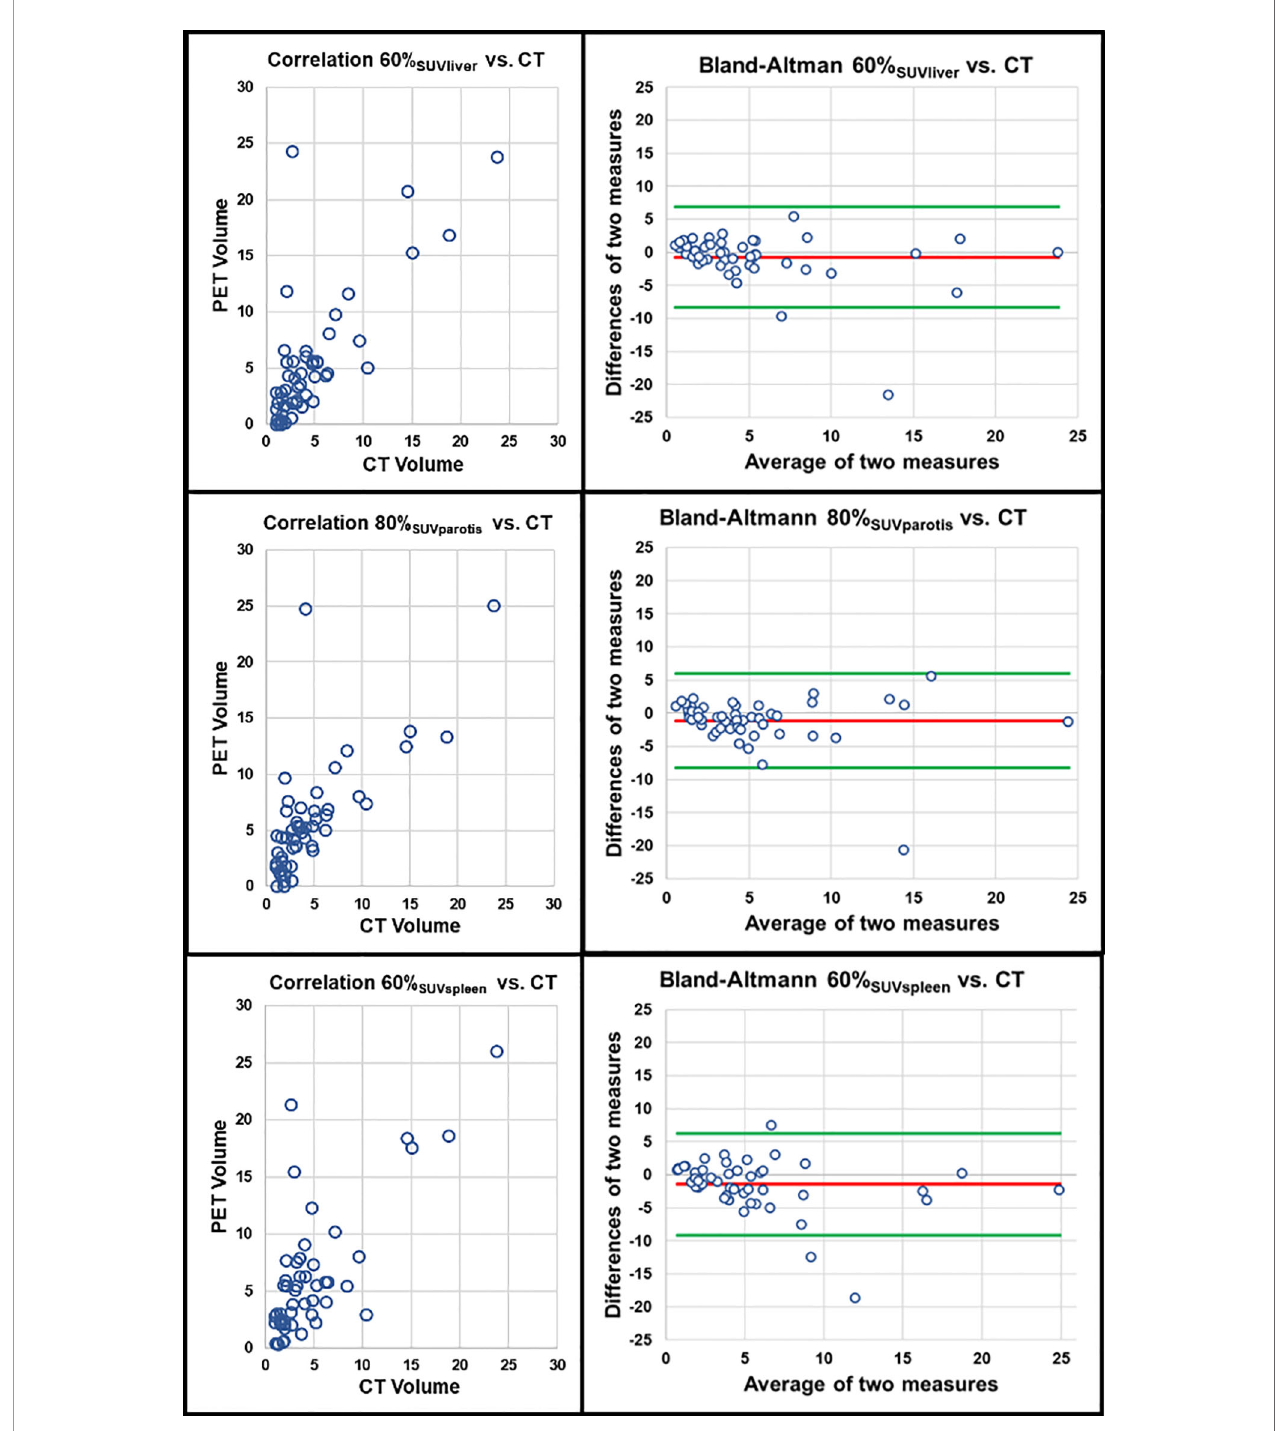
FIGURE 3 | Correlation of PET volumes using background tissue and CT-based reference standard. Upper row: PET volume 60% SUV liver (r = 0.715, r 2 = 0.511, p < 0.001). Middle row: 80% SUV parotis (r = 0.762, r 2 = 0.581, p < 0.001). Lower row: PET volume 60% SUV spleen (r = 0.645, r 2 = 0.412, p < 0.001); each correlation plot is accompanied by the respective Bland-Altman plot (red line: mean difference of two measures. Green lines: mean difference of two measures ± 1.96 x standard